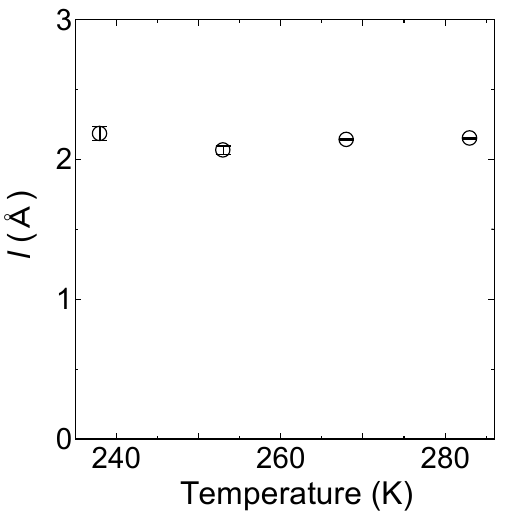
Figure 14. Temperature dependence of the jump distance l for the mobile hydrogen atoms at 238, 253, 268, and 283 K, as determined from the relationship l = √6𝐷𝜏 . The errors estimated from the fitting procedure are indicated by bars.